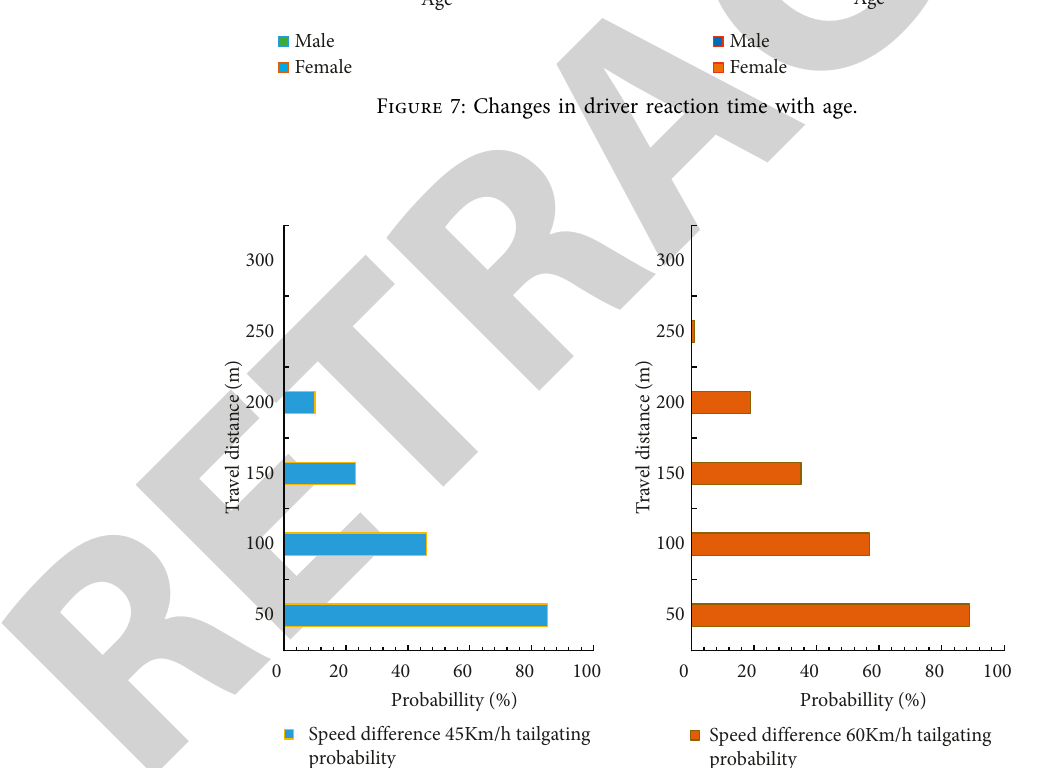
Figure 7: Changes in driver reaction time with age.